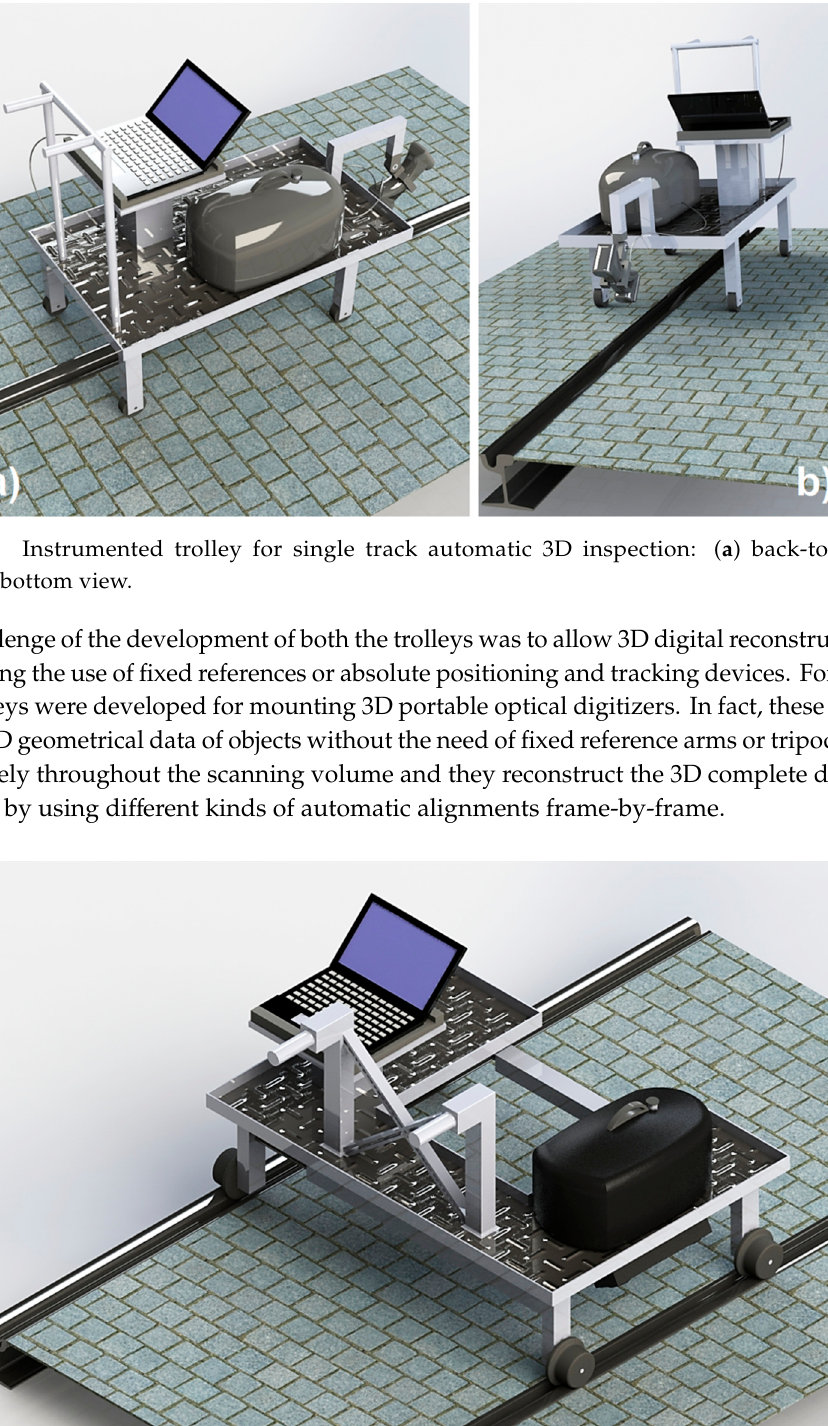
Figure 9. 3D scanners on the trolley: ( a ) right side; ( b ) left side. The challenge of the development of both the trolleys was to allow 3D digital reconstructions of the tracks, avoiding the use of fixed references or absolute positioning and tracking devices. For this reason, both the trolleys were developed for mounting 3D portable optical digitizers. In fact, these instruments can acquire 3D geometrical data of objects without the need of fixed reference arms or tripods. They can be moved freely throughout the scanning volume and they reconstruct the 3D complete digital model of the objects by using different kinds of automatic alignments frame-by-frame. On both the trolleys, the 3D scanning sensors were mounted on rotating or articulated arms. In the first trolley, the single 3D digitizer needed to be rotated around the pitch and roll axes and thus, it was mounted on an articulated two degrees of freedom (DOFs) arm. The twin trolley had one 3D sensor for each side of the track. In this case, the sensors just needed to roll. Both the trolleys were conceived to allow the measurement of a single track in all its parts, but the second configuration was also developed to allow the measurement of geometrical parameters also, like track gauge, cant, crooked and lateral wear (Figure 10), which need a twin configuration to